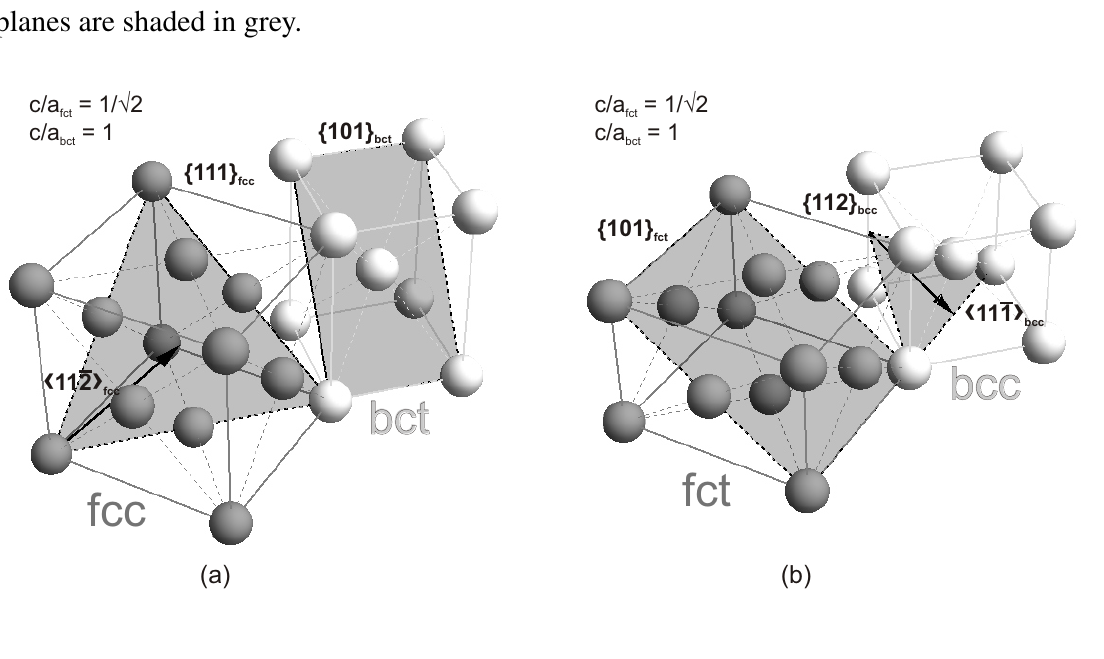
(cid:104) 112 (cid:105) and ( b ) bcc (body-centered fcc fcc (cid:104) 111 (cid:105) twinning mode. Common lattice bcc bcc